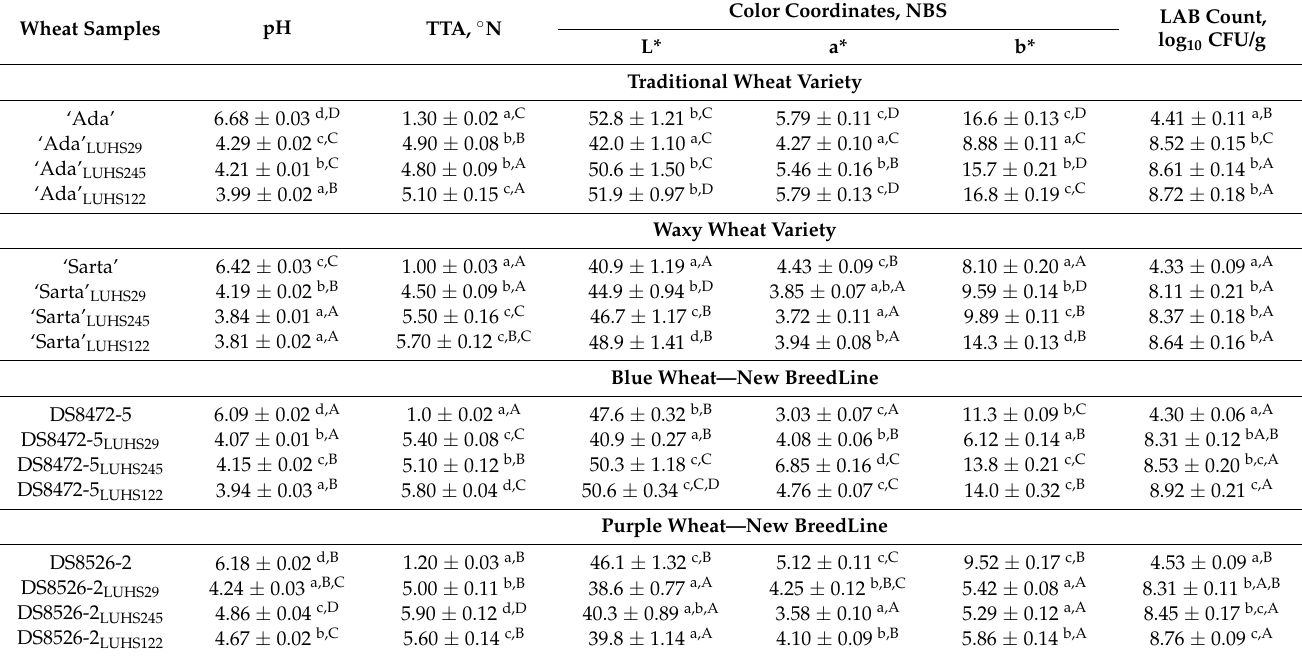
Table 1. Acidity, chromaticity, and microbiological characteristics of the wheat wholemeal samples. Color Coordinates, NBS Wheat Samples pH TTA, ◦ N Traditional Wheat